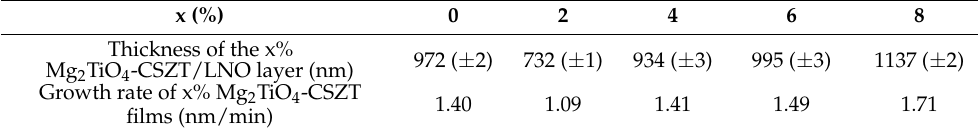
Table 2. The thickness and the growth rate of the x% Mg 2 TiO 4 -CSZT/LNO thin films. x (%) 0 2 4 6 8 Thickness of the x% 972 ( ± 2) 732 ( ± 1) 934 ( ± 3) 995 ( ± 3) 1137 ( ± 2) Mg 2 TiO 4 -CSZT/LNO layer (nm) Growth rate of x% Mg 2 TiO 4 -CSZT 1.40 films (nm/min) The dependence of DC voltage and frequency to dielectric permittivity and dielec- tric loss were measured at room temperature and shown in Figure 3. Both dielectric permittivity-frequency curve and the dielectric permittivity-DC voltage curve display